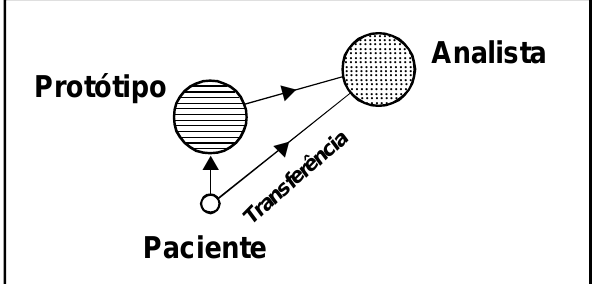
Figura 2 . Esquema construído, em analogia ao de Searle (1995), para a compreensão da